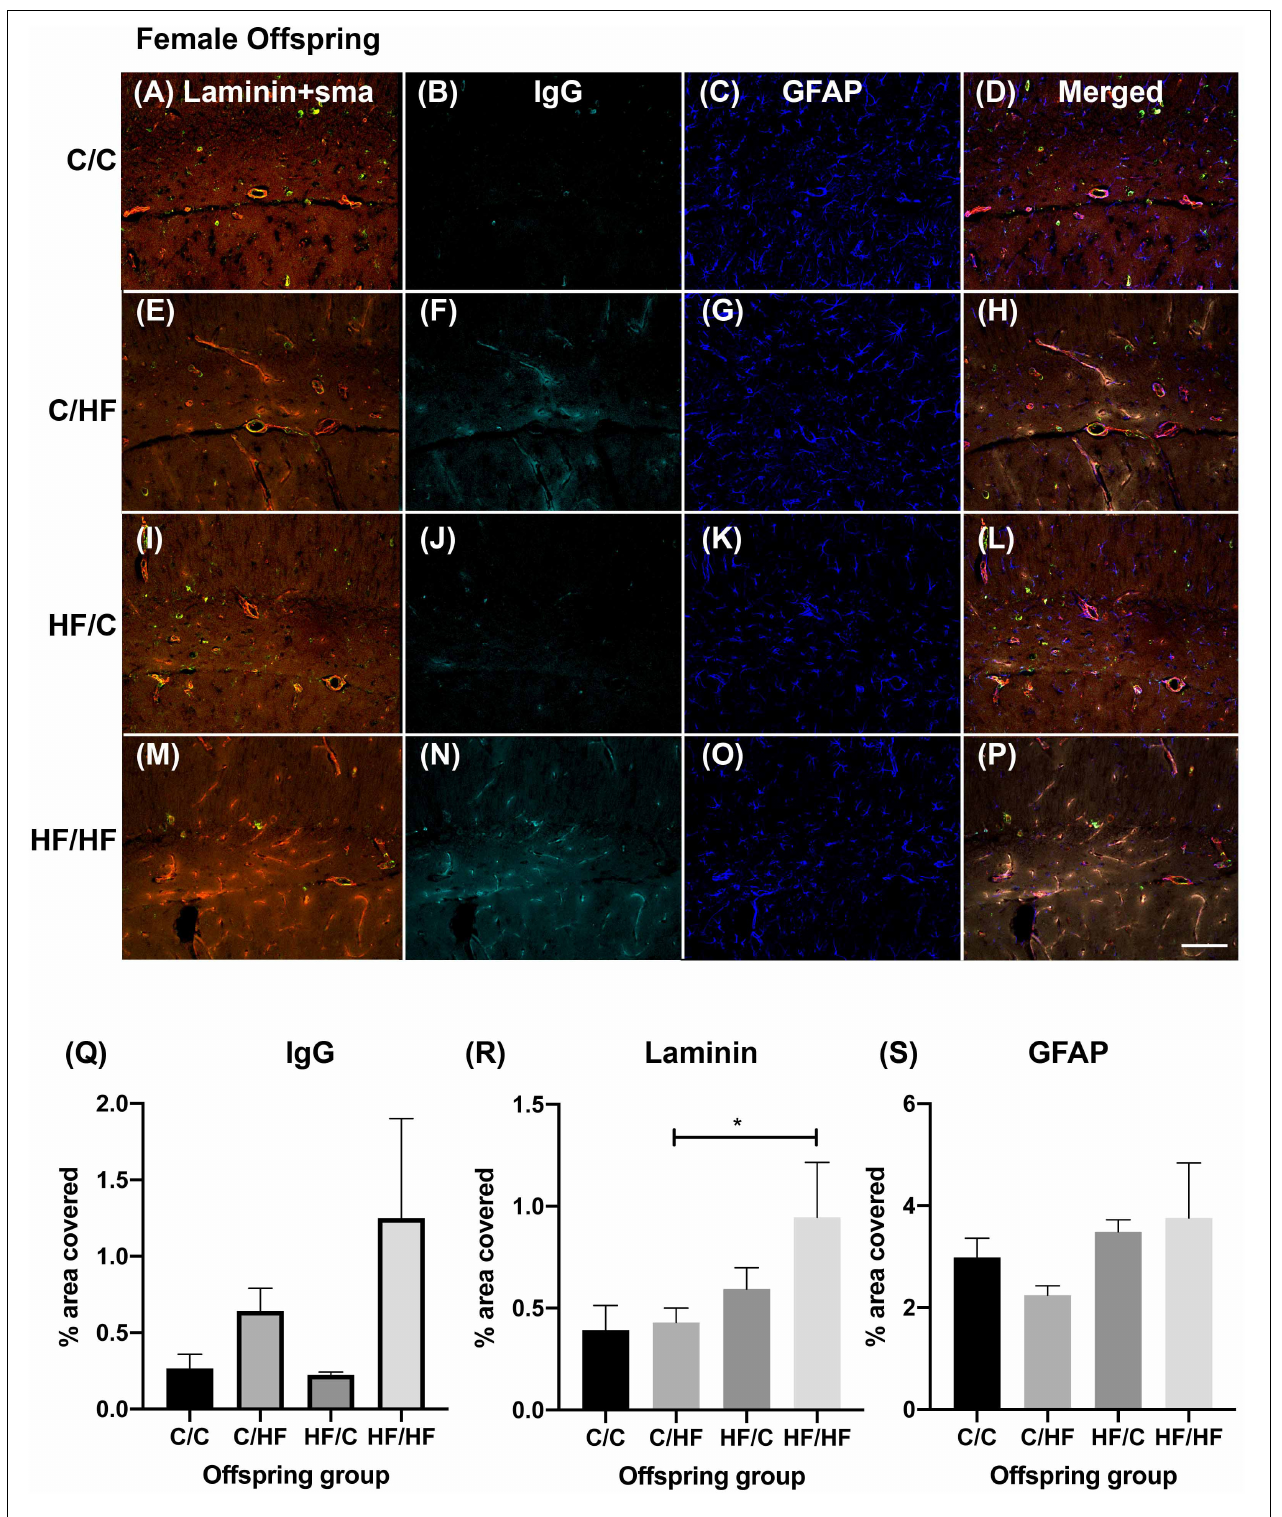
FIGURE 4 | Effect of pre- and post-natal high fat diet on hippocampal blood–brain barrier integrity in female offspring. (A) Photomicrographs of hippocampal tissue sections stained for laminin (red, A,E,I,M ), smooth muscle actin (green, A,E,I,M ), IgG (turquoise, B,F,J,N ) and GFAP (blue, C,G,K,O ) in 16-month old male C/C (A–D) , C/HF (E–H) , HF/C (I–L) and HF/HF mice (M–P) . (Q–S) Quantification of hippocampal area positive for IgG extravasation (Q) , laminin (R) and GFAP (S) . Data represent mean ± SEM. ∗ p < 0.05, two-way ANOVA with Holm–Sidak post hoc test. Scale bar = 100 µ m.